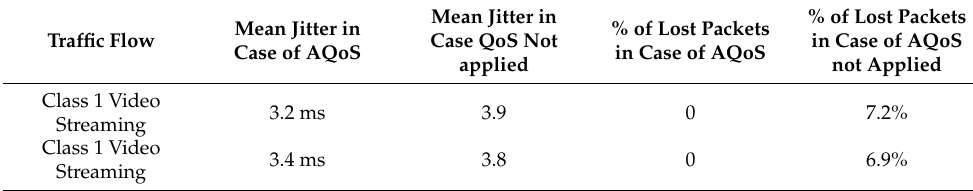
Figure 13. Throughput obtained in Scenario 2 in case of applying and without applying proposed adaptive QoS model for 120-s BE traffic flow, ( a ) Throughput obtained in Scenario 2 in case of applying proposed model, ( b ) Throughput obtained in Scenario 2 without applying proposed adaptive QoS model for 120-seconds BE traffic flow. Table 11. Scenario 2 Video Streaming Performance Results.